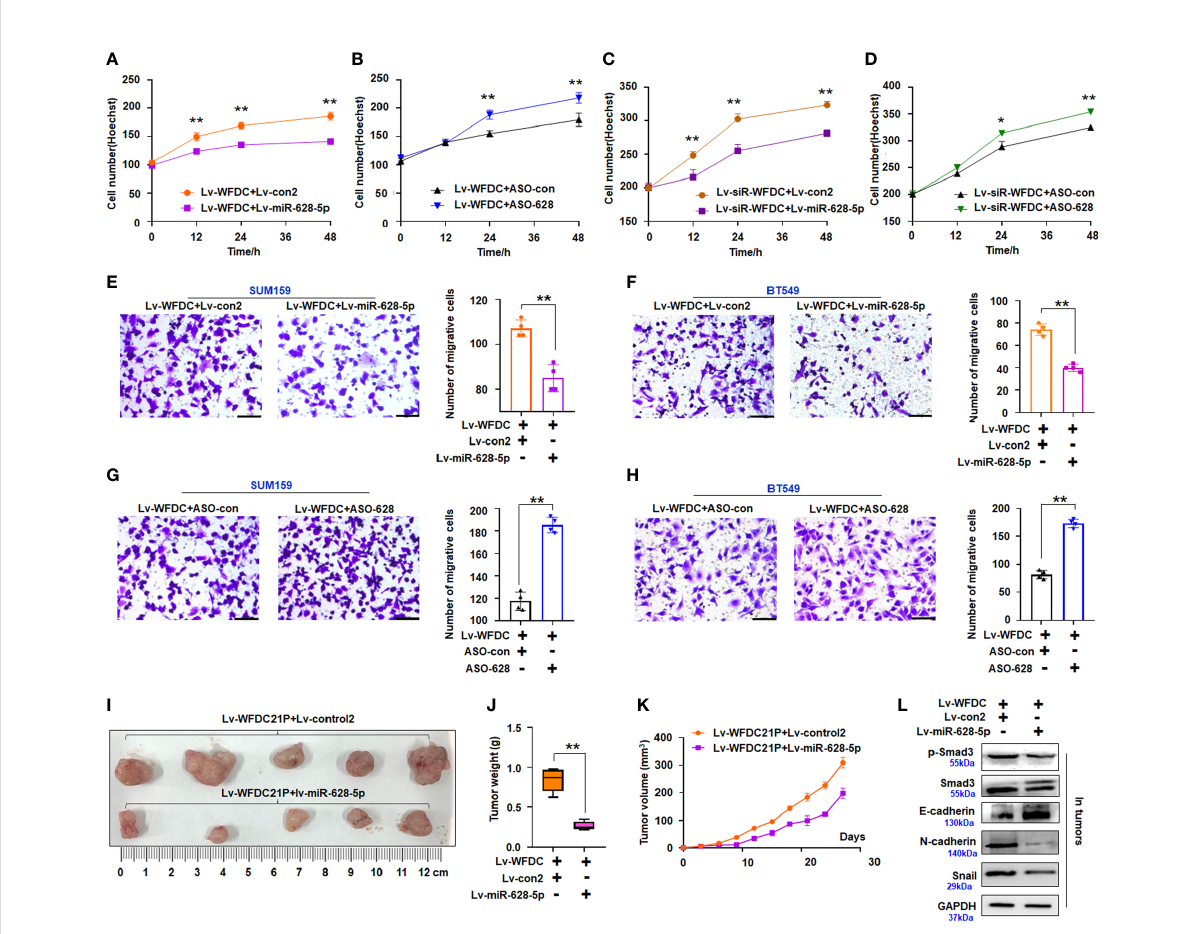
FIGURE 5 Effect of miR-628-5p on oncogenic roles of WFDC21p. (A – D) Hoechst staining assay. miR-628-5p treatment attenuated but ASO-628 treatment enhanced the promoting effect of WFDC21P on SUM159 cell proliferation. miR-628-5p treatment increased but ASO-628 treatment weakened the suppressive effect of siRNA-WFDC21P on SUM159 cell proliferation. Data are expressed as the mean ± SD of triplicate experiments. * p < 0.05, ** p < 0.01; Student ’ s t-test. (E – H) Effect of miR-628-5p treatment on the promoting effect of WFDC21P on TNBC cell metastasis. Data are expressed as the mean ± SD of triplicate experiments. ** p < 0.01; Student ’ s t-test. (I – K) Tumor size, weight, and volume changes were measured after xenografts were treated with miR-628-5p+WFDC21P. Data are expressed as mean ± SD or median